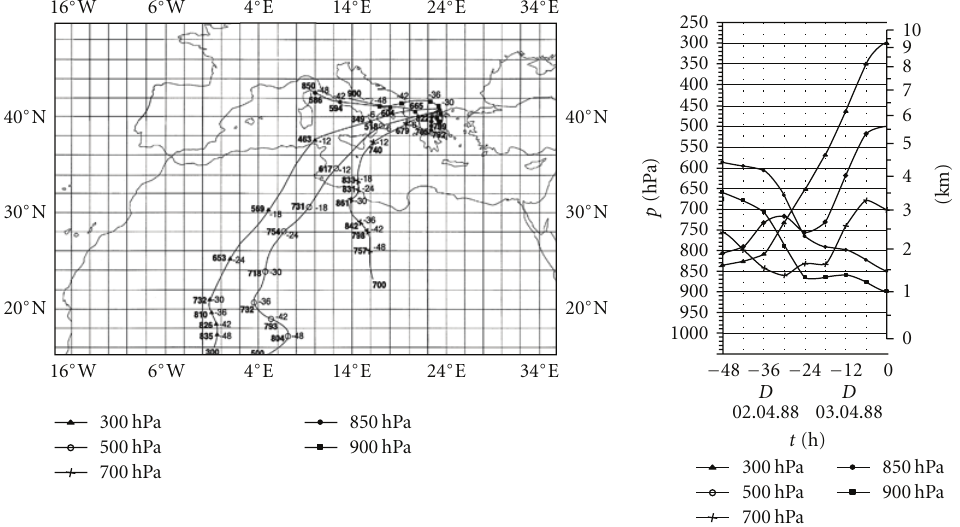
Figure 12: Same as Figure 8(b), but for 00:00 UTC on 4 April